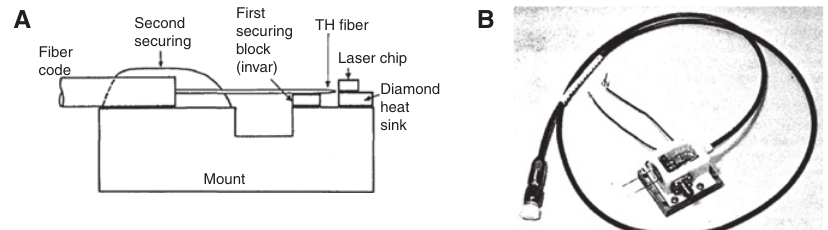
Figure 1: Conventional coupling schemes for semiconductor lasers. (A) Schematic diagram of end-fire coupling for fiber-to-laser connection. (B) An example of a packaged single-mode coupler. Reprinted from Ref. [18]. Copyright (1980) The Optical